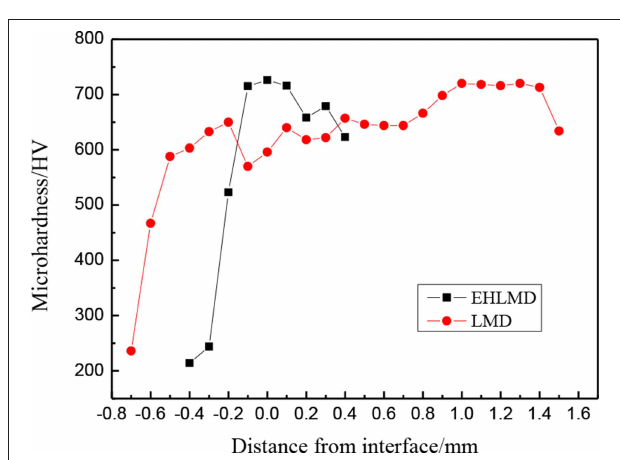
FIGURE 8 | Microhardness distribution of two kinds of deposition